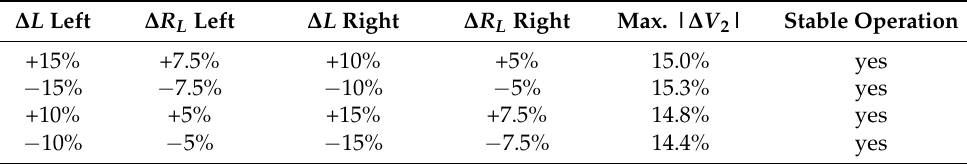
Table 6. Results of robustness analysis against variations of L and R L in Scenario